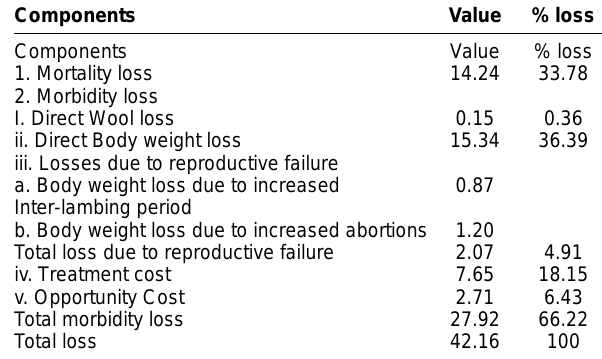
Table-6. Component and species wise losses due to PPR in sheep (Rs. In lacs)